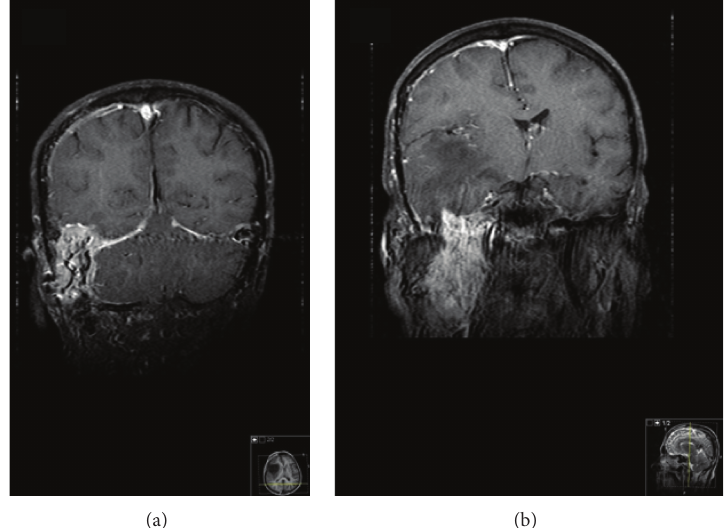
Figure 2: Cranial magnetic resonance images demonstrate (a) a mass lesion that arises from the right jugular foramen, extending to the medial cranial fossa, consistent with glomus jugulare, and (b) a mass lesion at the carotid bifurcation, consistent with glomus caroticum.